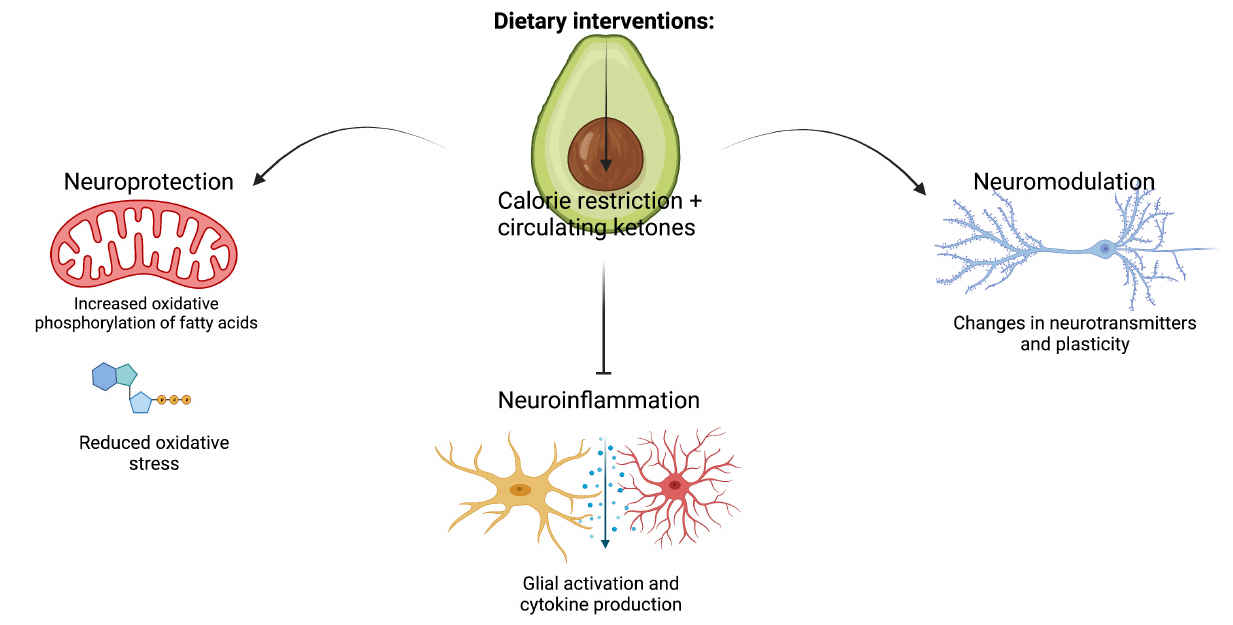
FIGURE 2 | Summary of the key cellular mechanisms that mediate the effects of KD and CR on brain health: neuroinflammation, neuroprotection and neuromodulation. Figure created with